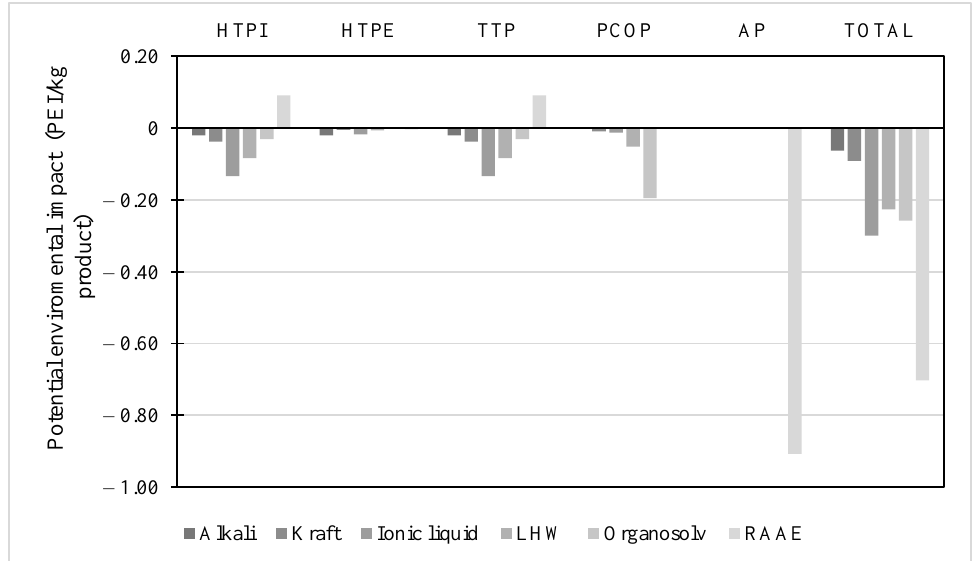
Figure 4. Potential environmental impact of pretreatment schemes for lignin isolation.